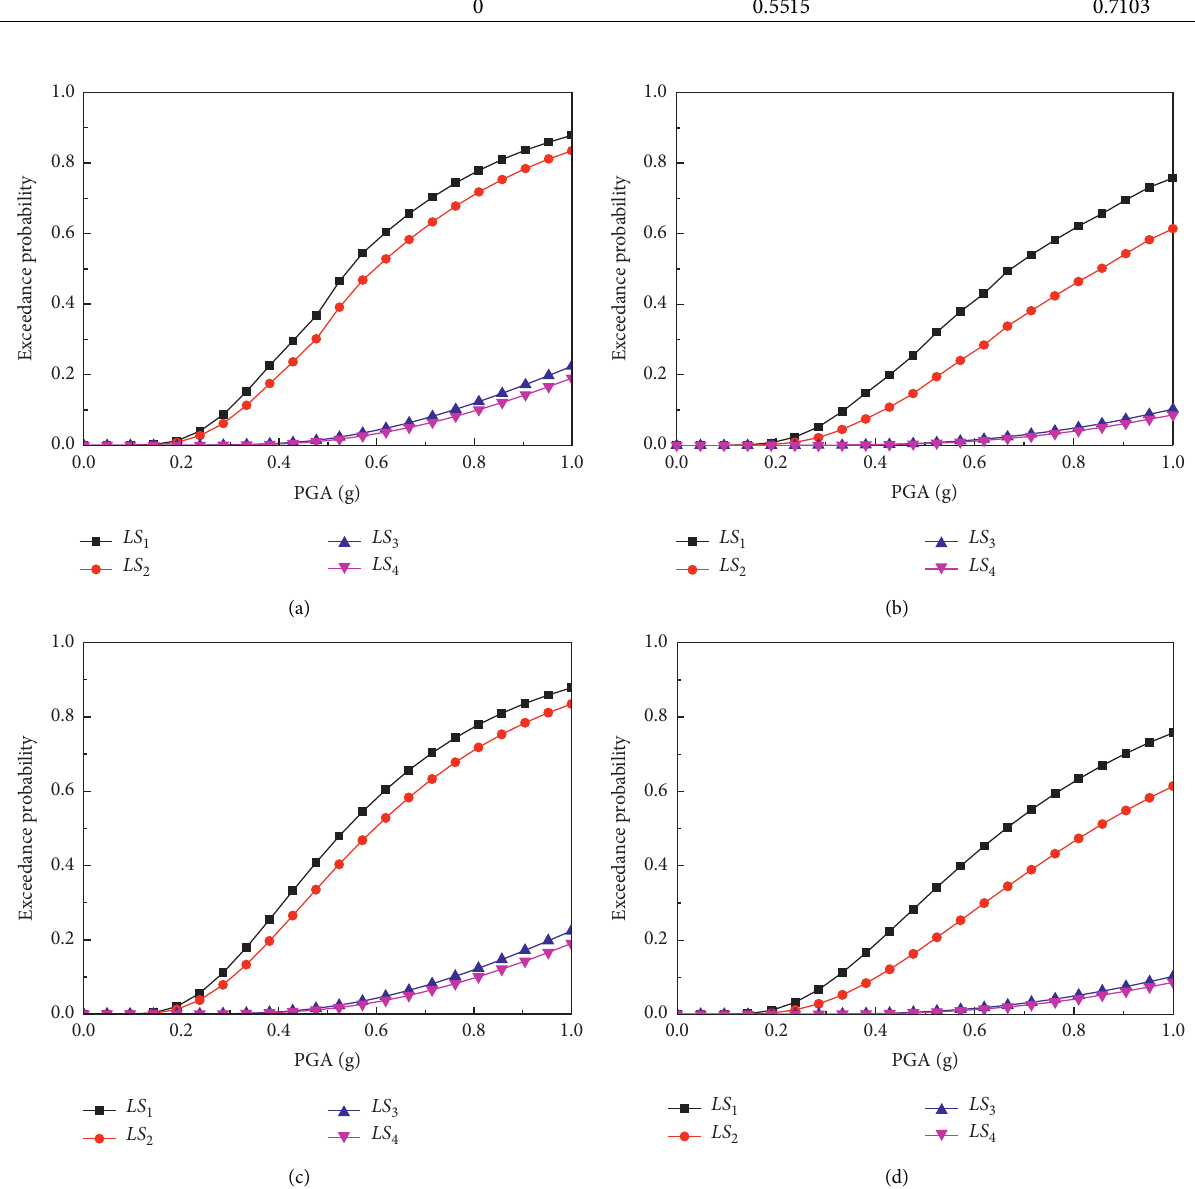
Figure 7: Vulnerability curve of control section: (a) vulnerability curve of RC pier top section, (b) vulnerability curve of RC/ECC pier top section, (c) vulnerability curve of RC pier bottom section, and (d) vulnerability curve of RC/ECC pier bottom section.